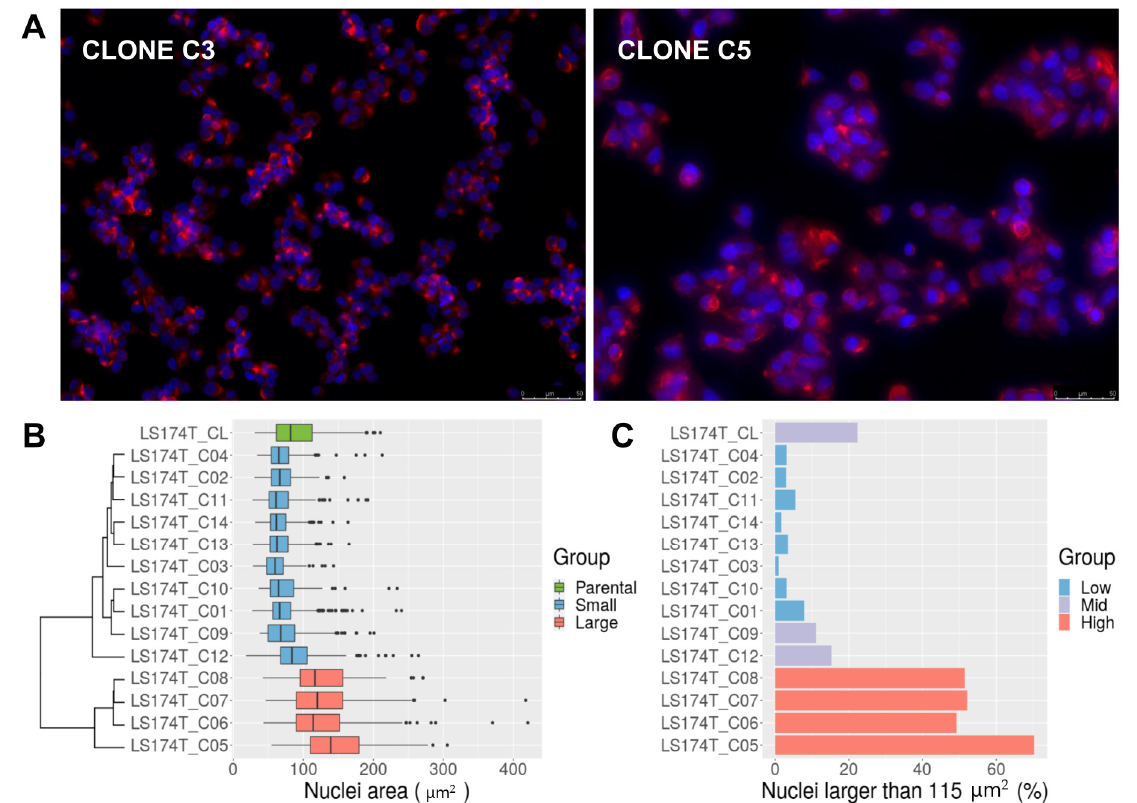
Figure 1. ( A ) Morphological analysis of LS174T clones. The figure shows a small cell size clone (C3) and a large cell size clone (C5) stained with phalloidin (red, cytoskeleton) and DAPI (blue, nuclei). Pictures were taken at 200 × magnification. Scale bar 50 µ m is shown in the bottom right corner of the pictures. ( B ) Nuclei area of LS174T and derived clones, measured by microscopy after DAPI staining. The parental cell line (CL) in green. Clones are colored according to the average nuclei size into small (blue) and large (red) and classified by unsupervised clustering based on the difference of their average nuclei size (dendrogram on the left). ( C ) Percentage of nuclei with areas larger than 115 µm 2 in LS174T and derived clones. Most of the clones exhibited a low proportion (less than 10%, low group, blue) of nuclei above 115 µm 2 . The parental cell line (CL) and clones C9 and C12 exhibited a larger proportion (10~25%, mid group, in purple). Clones C5–C8 exhibited around 50% of nuclei larger than that value (high group, in red).